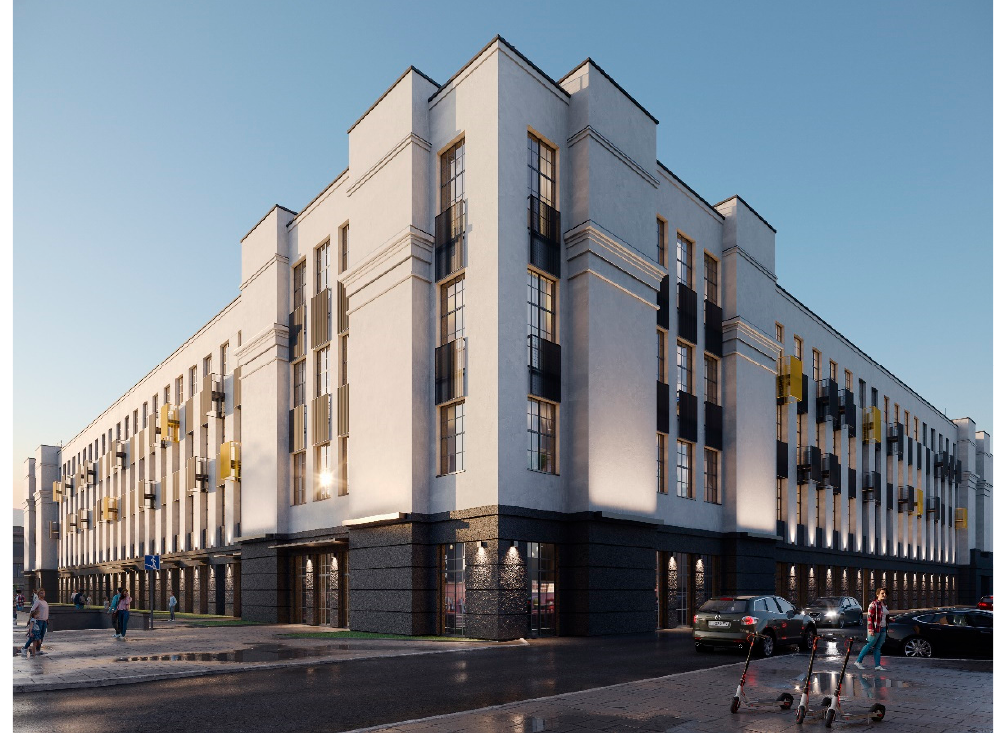
Figure 21. The facades of “Nida” and “Banga” (visualization courtesy of UAB Citus).